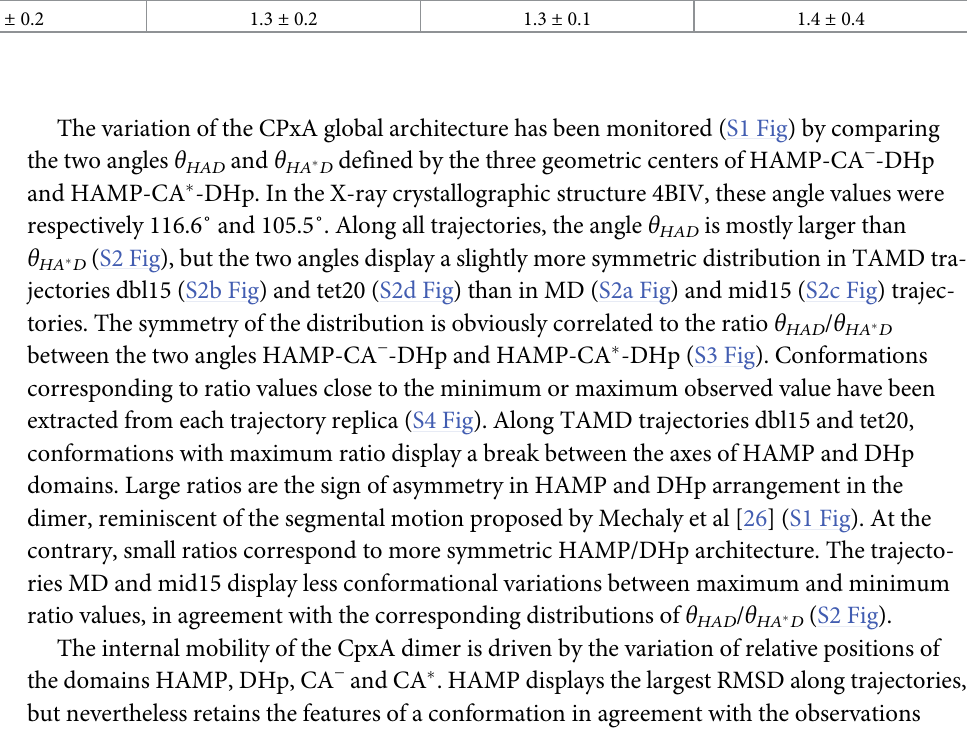
Table 2. Parameters describing the HAMP architecture calculated along each trajectory replica. The inter-monomer distance ( Å ) is calculated as the distance between geometric centers of C α from residues 189-203 and 217-231 of HAMP α helices in each monomer. The percentage of α helix is calculated on the same residues. Parameter HAMP Inter-monomer distance ( Å )